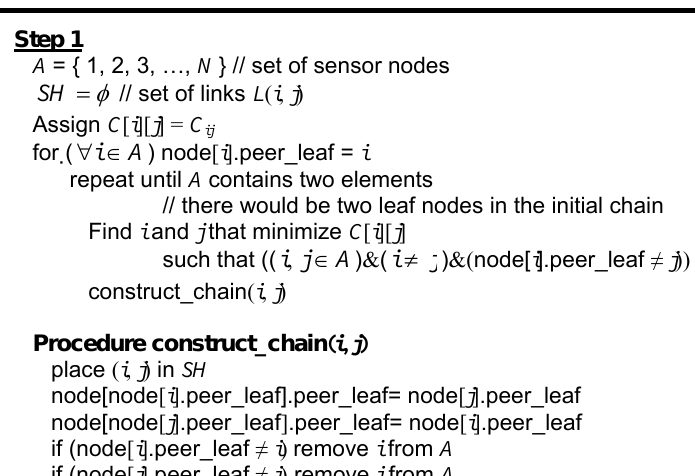
Figure 7. Chain construction